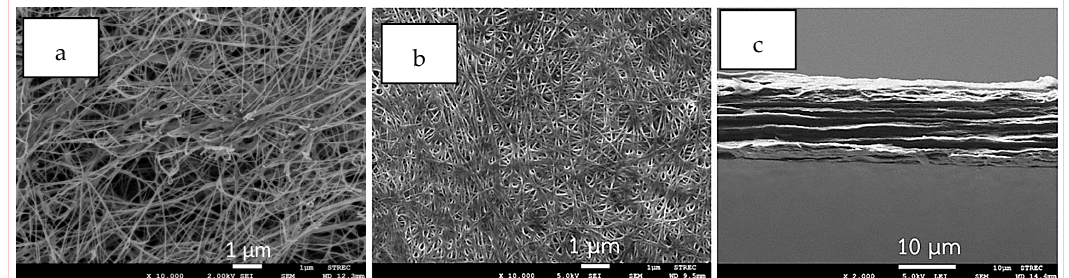
Figure 2. Field emission scanning electron microscopy (FESEM) images of surface morphologies of never dried films of bacterial cellulose (BC) ( a ) and dried BC films: surface ( b ) and cross section ( c ).